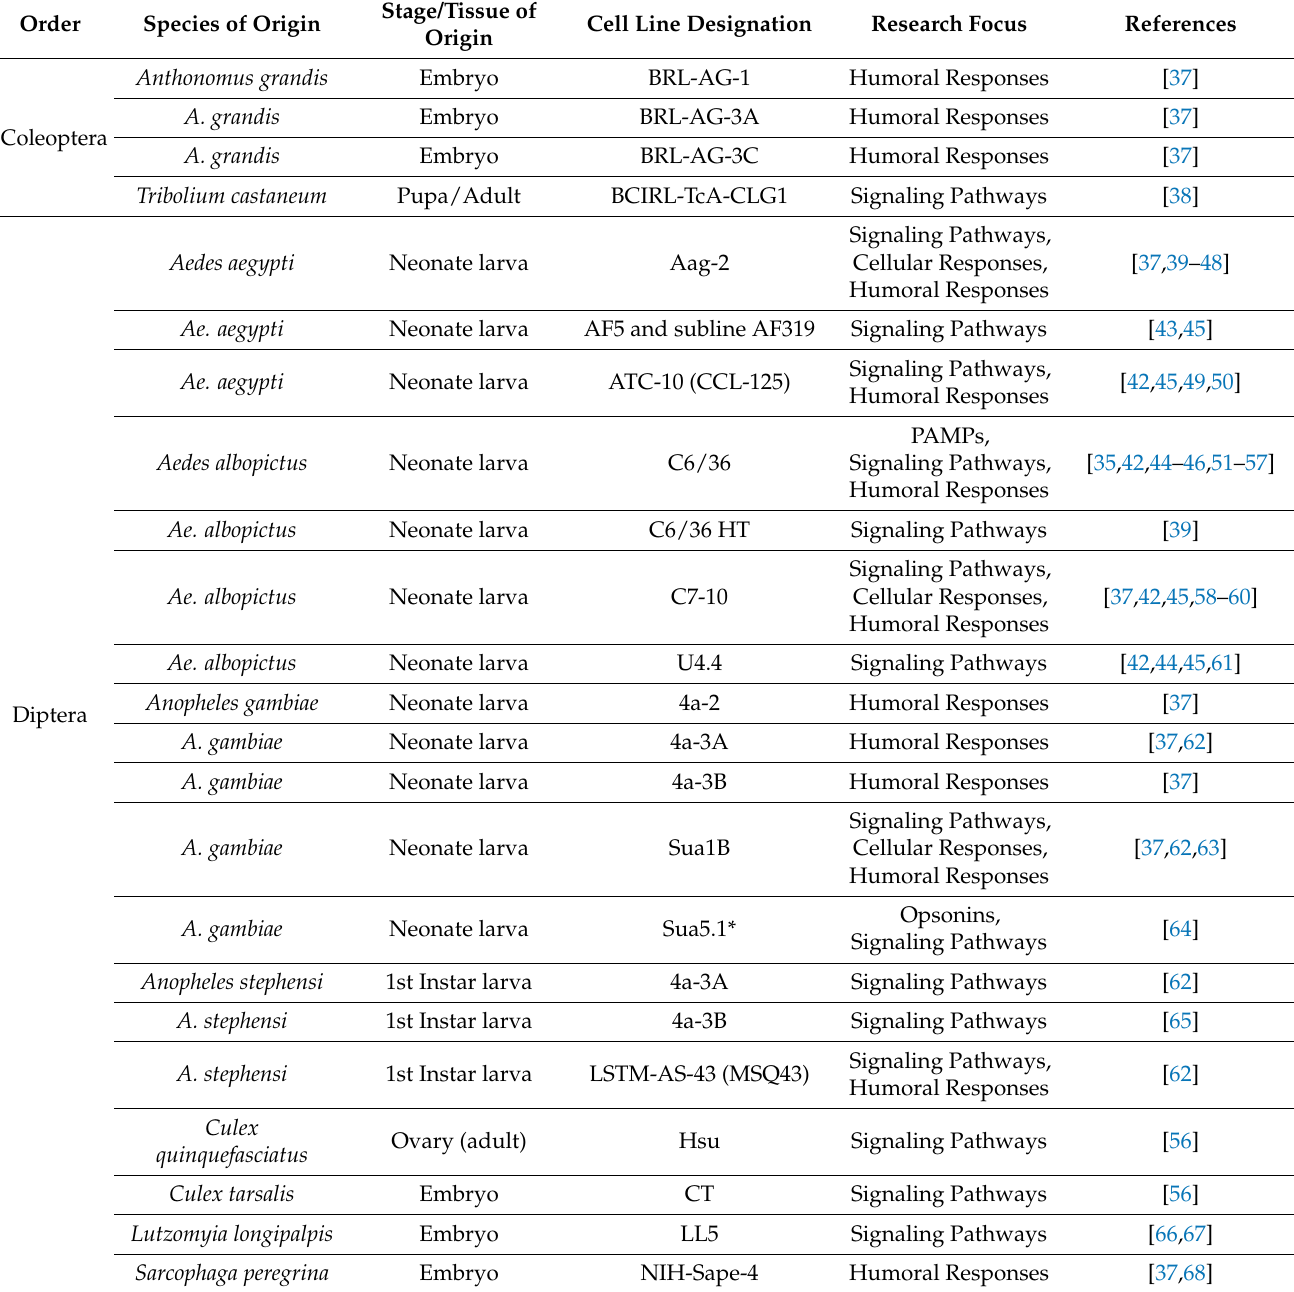
Table 2. Examples of the insect cell lines used in immune-related